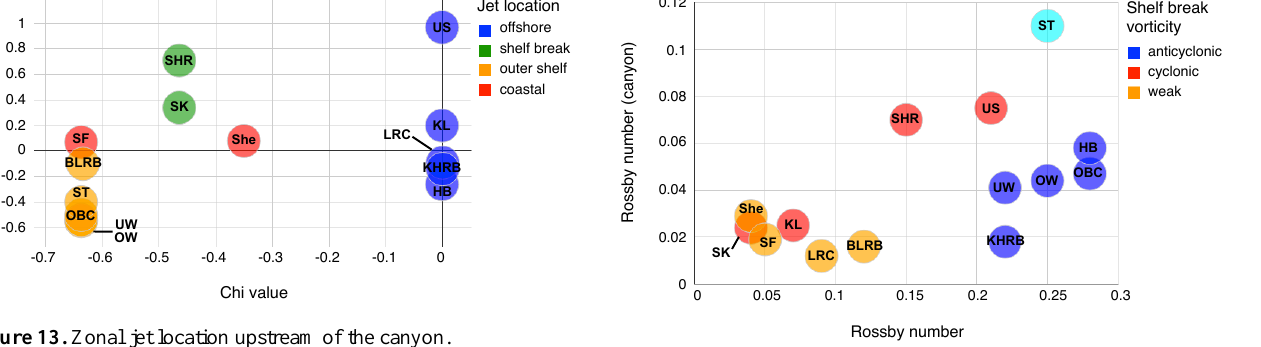
Figure 14. Correlation between Rossby numbers based on incom- ing zonal flow and zonal flow integrated across the canyon axis. Due to complex canyon topography, canyon Rossby number for ST is likely overestimated and ST is considered an outlier. Until now, the Rossby number has been based on incom- ing flow strength. However, a Rossby number based on flow across the canyon axis ( R ) may be more appropriate for U can looking at flow dynamics within the canyon. These values are compared in order to determine correlations between incom- ing and canyon axis flow (Fig. 14). Due to the more complex topography in the slanted canyon simulation (ST), it is sus- pected that R is overestimated for this scenario and is U can thus marked as a possible outlier in subsequent